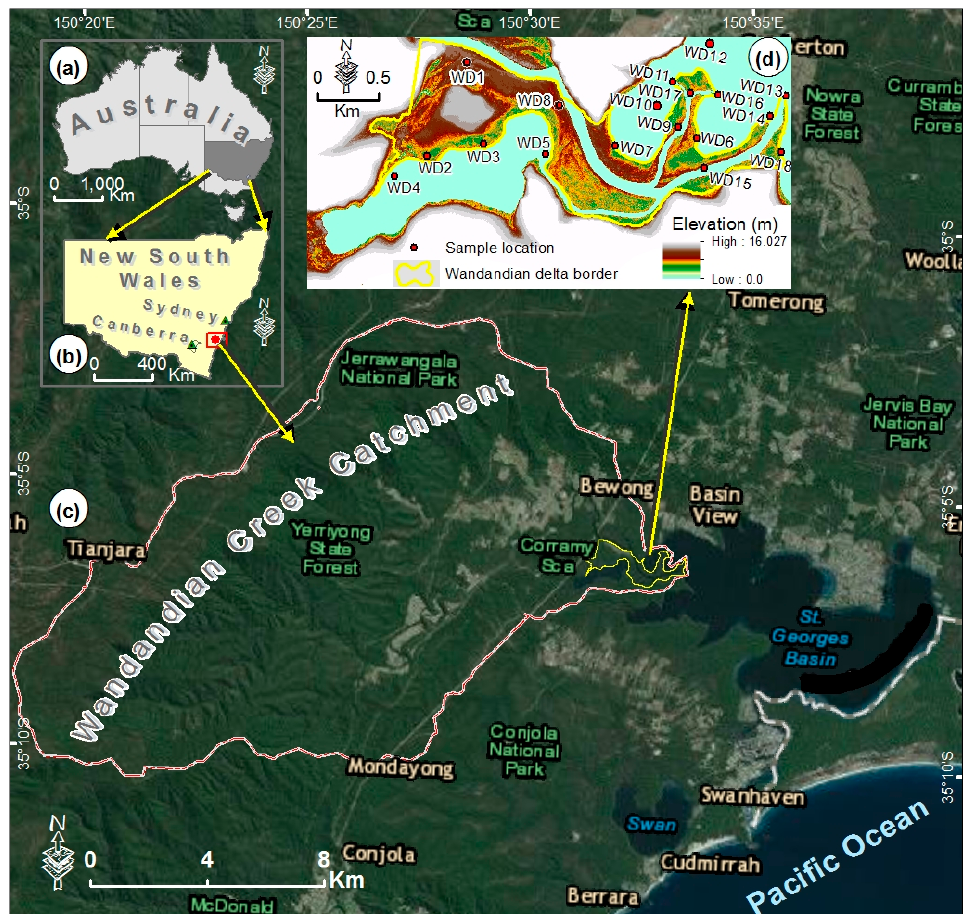
Figure 1. The study site, of the coastal deltaic section of Wandandian Creek, southeast NSW, Australia, illustrating; ( a ) location of New South Wales (NSW) in eastern Australia, ( b ) the study site located on the mid-southern NSW coast, ( c ) the regional setting showing the St. Georges Basin and the catchment area of Wandandian Creek, and ( d ) illustrates the deltaic border, elevation and the sampling locations (WD1 to WD18).